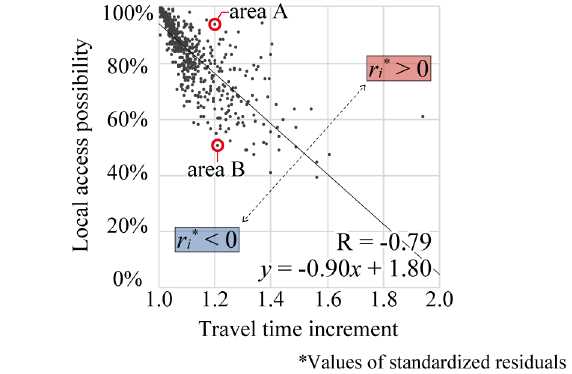
Figure 15. Comparison of TTI and LAP